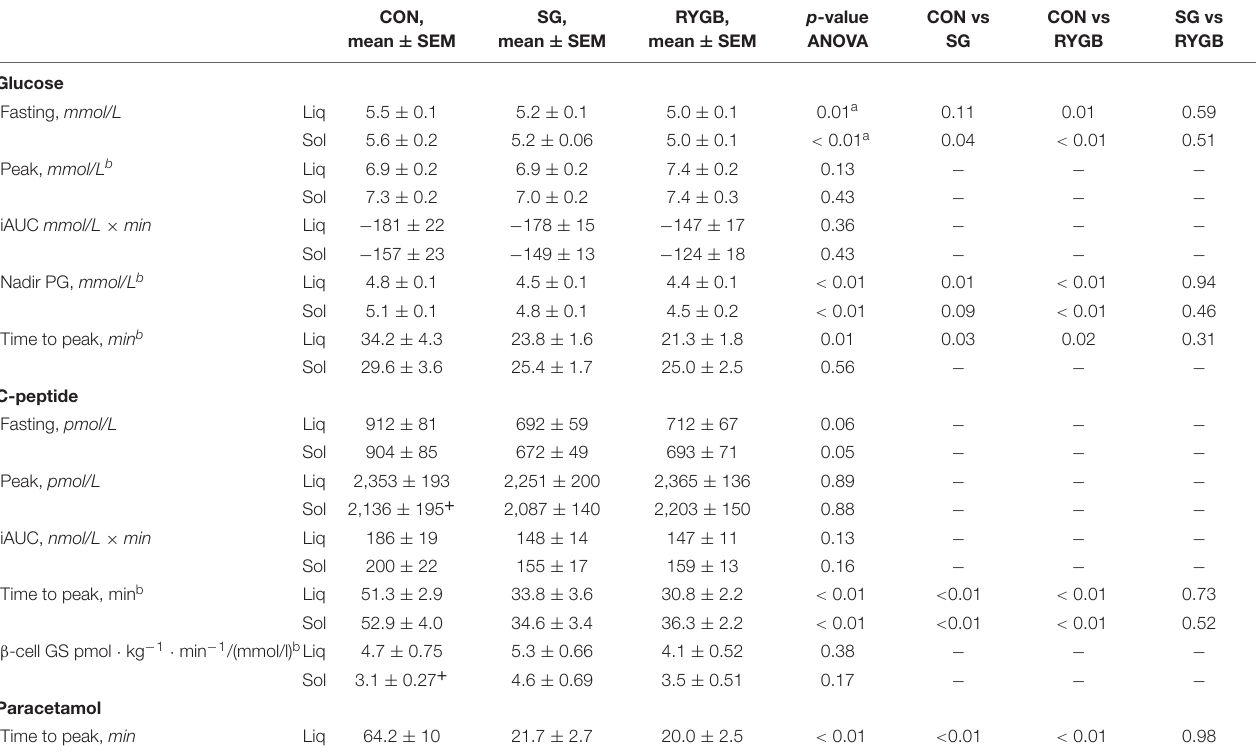
TABLE 1 | Postprandial glucose, C-peptide, and paracetamol concentrations on the two test days, liquid or solid meal.